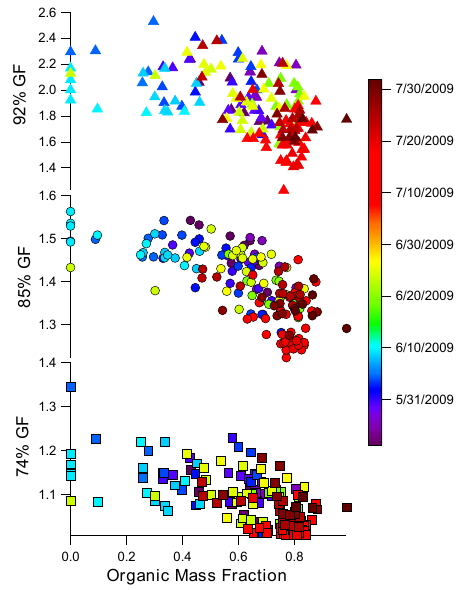
Fig. 9. GF at 74, 85, and 92% RH plotted against organic mass Fig.9. GFat74,85,and92%RHplottedagainstorganicmassfraction,withcolorscalecorrespondingtodate. fraction, with color scale corresponding to